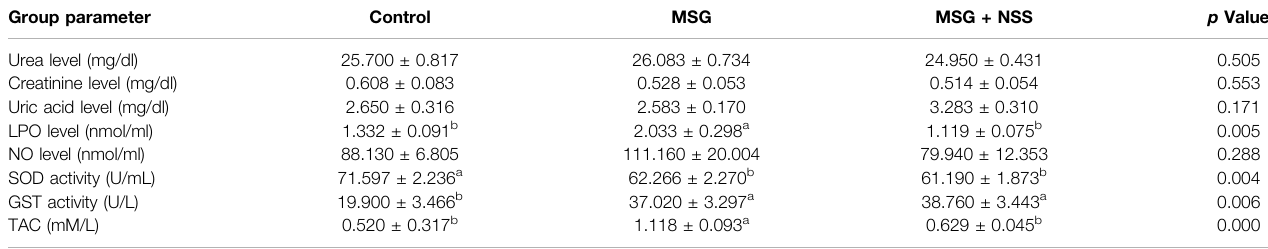
TABLE 1 | Effect of Nigella sativa L. seed on kidney function and oxidant/antioxidant parameters in the serum of monosodium glutamate challenged rats. Group